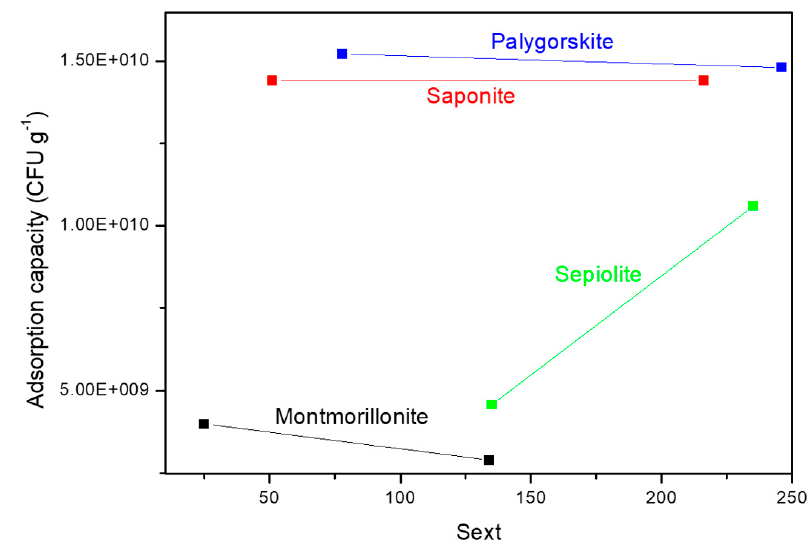
Figure 14. Salmonella adsorption capacity variations vs. external surface of the sorbent.